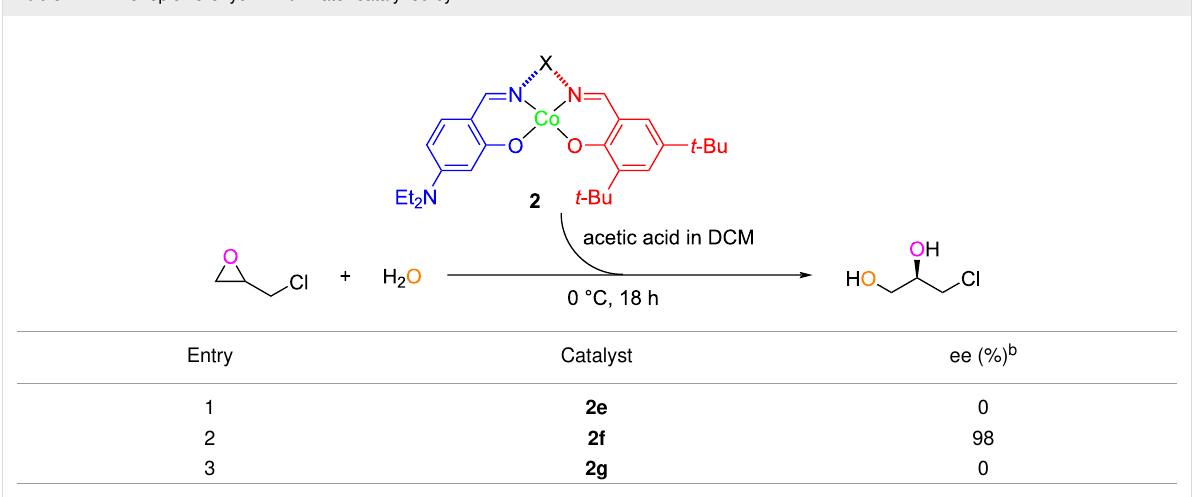
Table 2: HKR of epichlorohydrin with water catalyzed by 2 . a